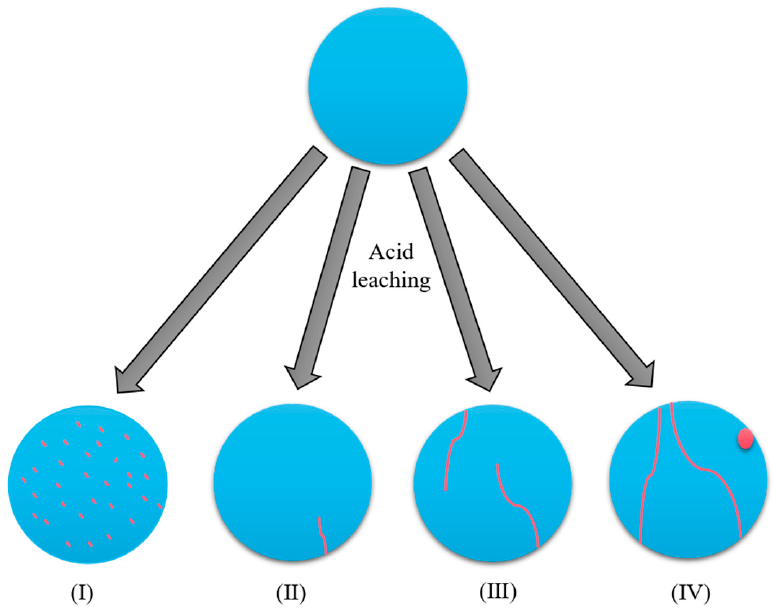
Figure 9. Diagram of the degree of breakage of pellets after acid leaching. (I) slightly powdery surface; (II) small crack: (III) servere: (IV)severe crushing.